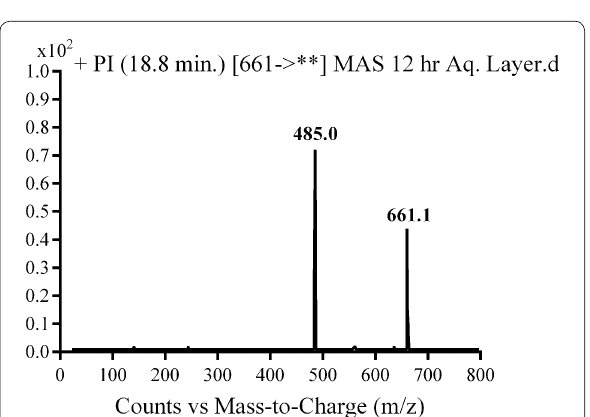
Fig. 17 PI mass spectrum of parent ion (MG2) at m/z 661 Fig. 18 PI mass spectrum of parent ion (MG3) at m/z 691